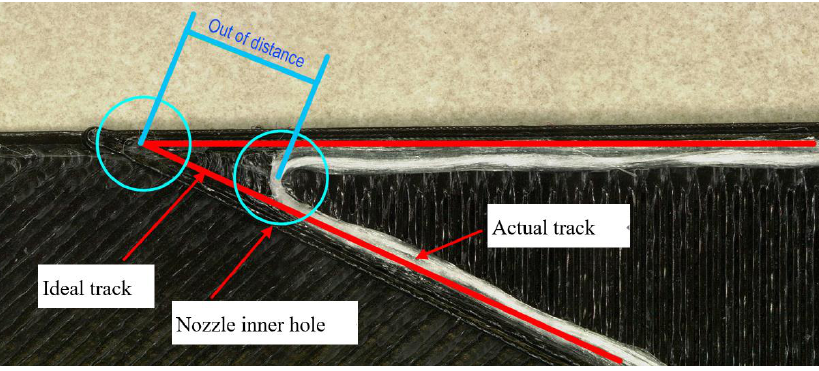
Figure 8. Ideal track and actual track.